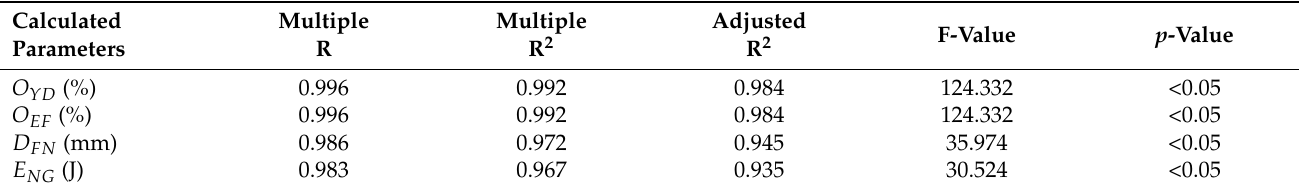
Table 3. Whole model test for the effect of the factors on the calculated parameters.